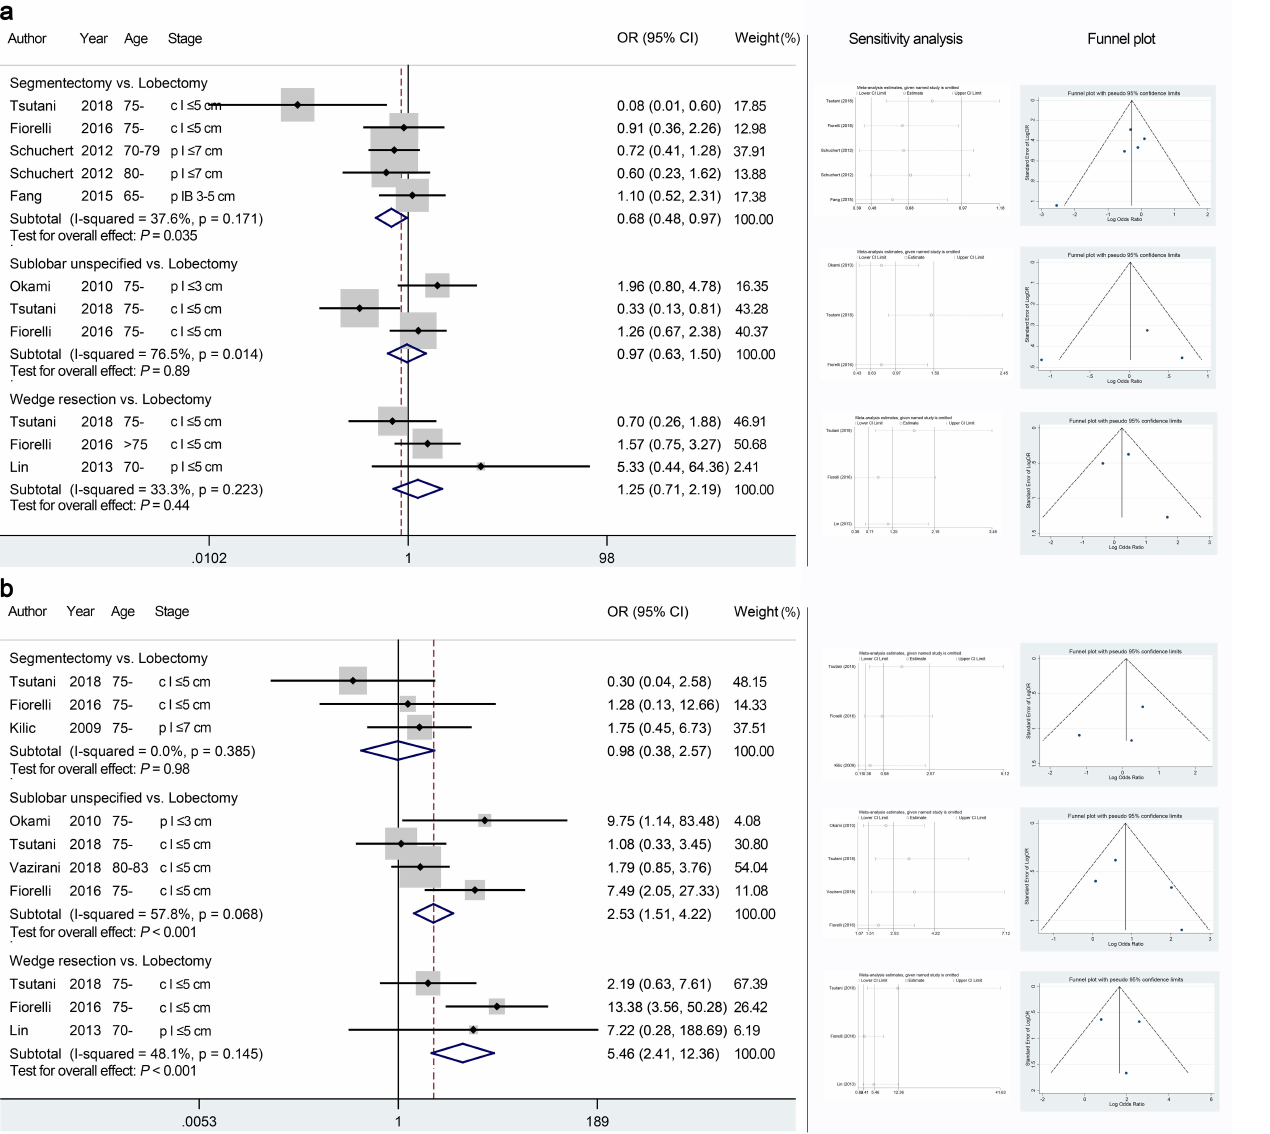
Figure 4. Meta-analyses comparing the overall recurrence risk ( a ) and local recurrence risk ( b ) of sublobar resections with those of lobectomy. The right panel presents the outcomes of sensitivity analyses and the funnel plots corresponding to the forest plots shown in the left panel. OR, odds ratio; CI, confidence